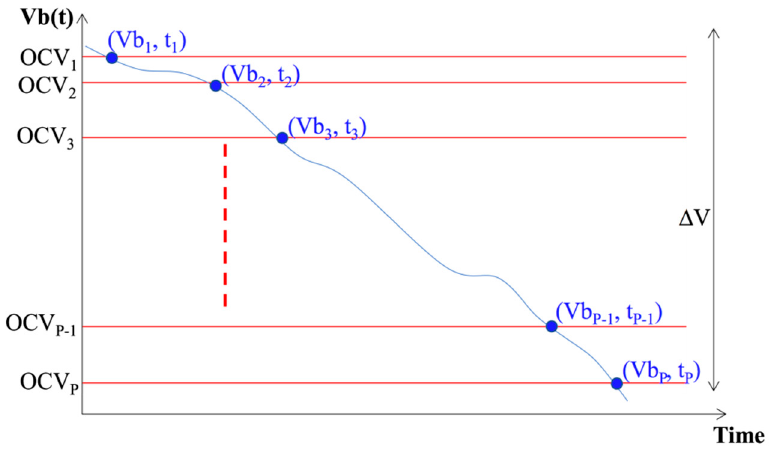
Figure 7. The principle of Vb(t) acquisition.